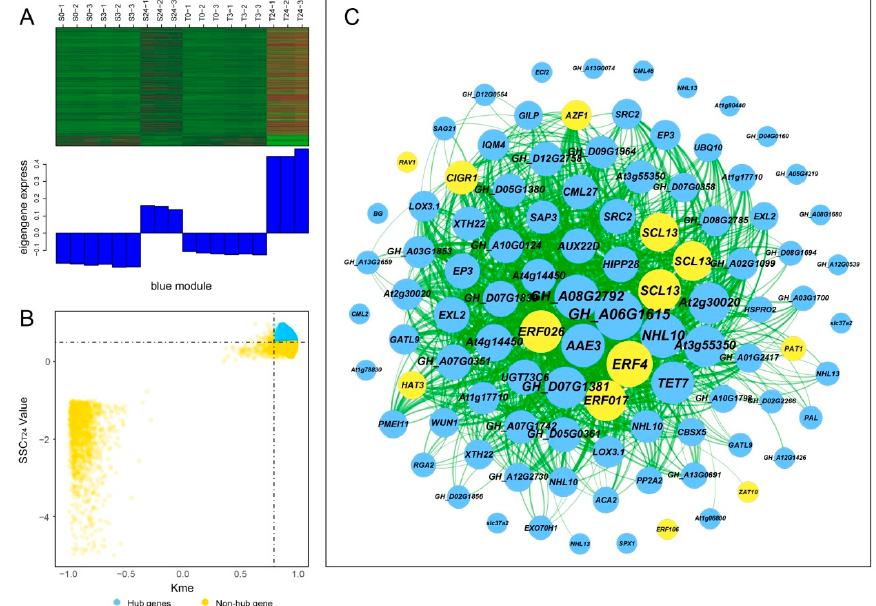
Figure 7. Coexpression network construction of the blue module. ( A ) Gene coexpression heatmap of the blue module (upper panel) and expression level of the corresponding eigengene in each sample (lower panel). ( B ) Dot plot mining hub genes with higher module connectivity and expression levels at T24. The X-axis represents the connectivity values (Kme) of genes in the blue module, while the Y-axis represents the dominant expression value (SSC T24 ) of the genes at T24. Genes with Kme > 0.8 and SSC T24 > 0.5 were identified as hub genes (blue dots). ( C ) The coexpression network of hub genes in the blue module. The top 100 hub genes with weight value > 0.45 and higher expression levels at T24 were used to construct the network. The node size indicated gene degree, and the color was used to distinguish whether it was a transcription factor gene (orange node). Line thickness between nodes reflects the weight value.